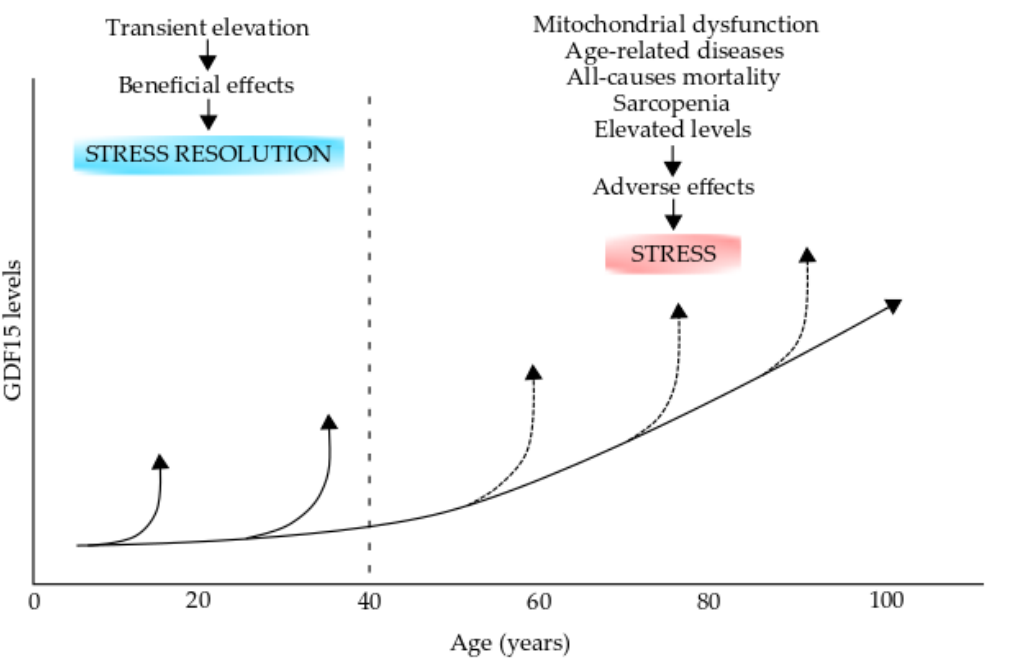
Figure 5. Growth differentiation factor 15 (GDF15) levels in aging and aging-related diseases. The GDF15 levels increase during the process of normal aging. GDF15 transient elevations during early life (up to 40 years old) could have beneficial effects on stress resolution However, these levels can increase over the normal levels (broken arrows) in individuals over 40 years old and could have adverse effects and produce stress. Elevated levels are produced during mitochondrial dysfunction, age-related diseases, all-cause mortality, and sarcopenia. This figure was modified from reference [269].